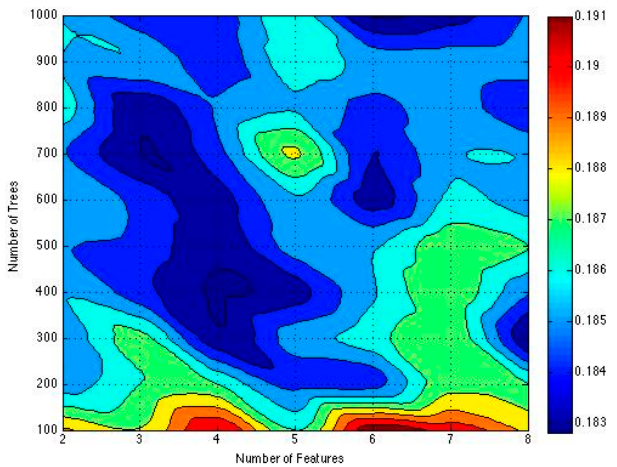
Figure 11. OOB error result distribution.